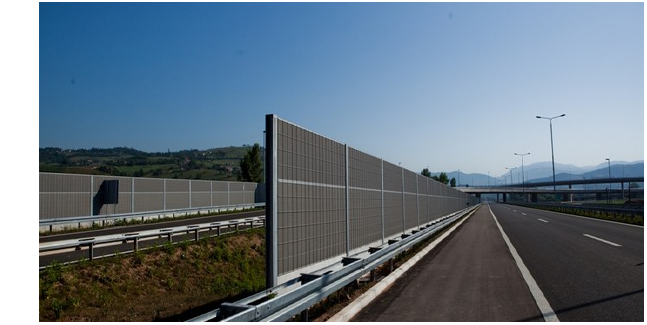
Figure 6 – Barriers for protection against noise Рис . 6 – Шумозащитный